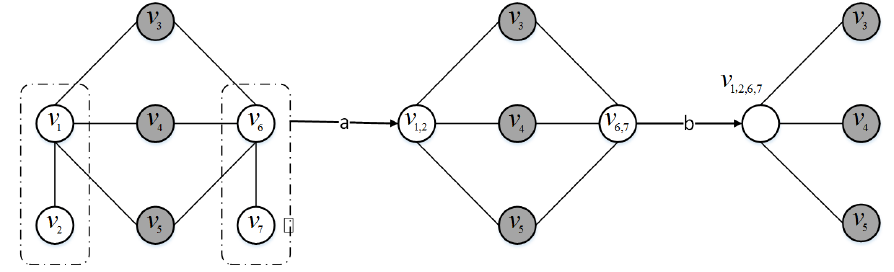
Figure 2. Example of network graph layering